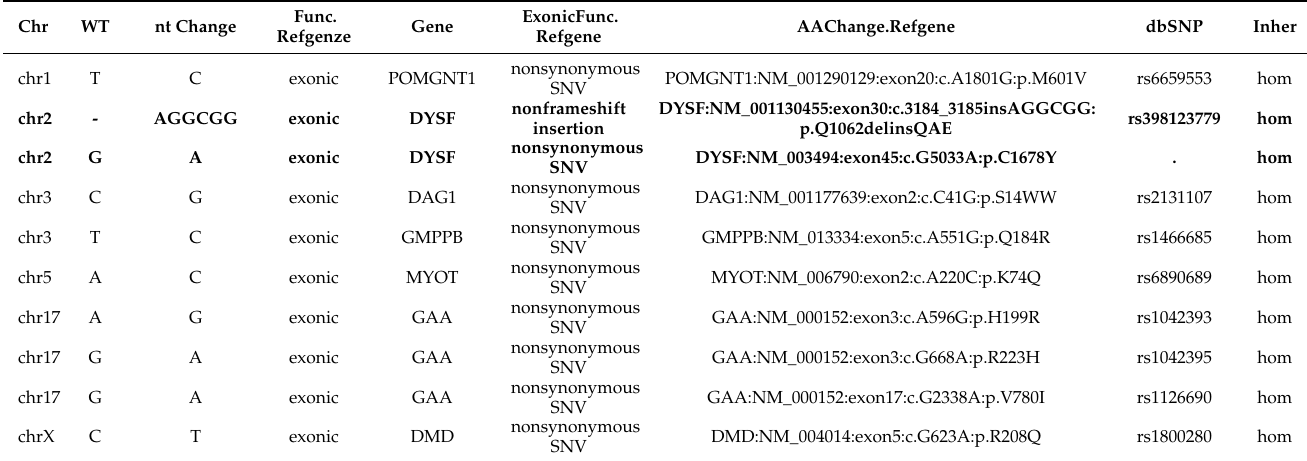
Table 1. Variations identify by NGS after filtering. In bold are indicated the two variants investigated in the family